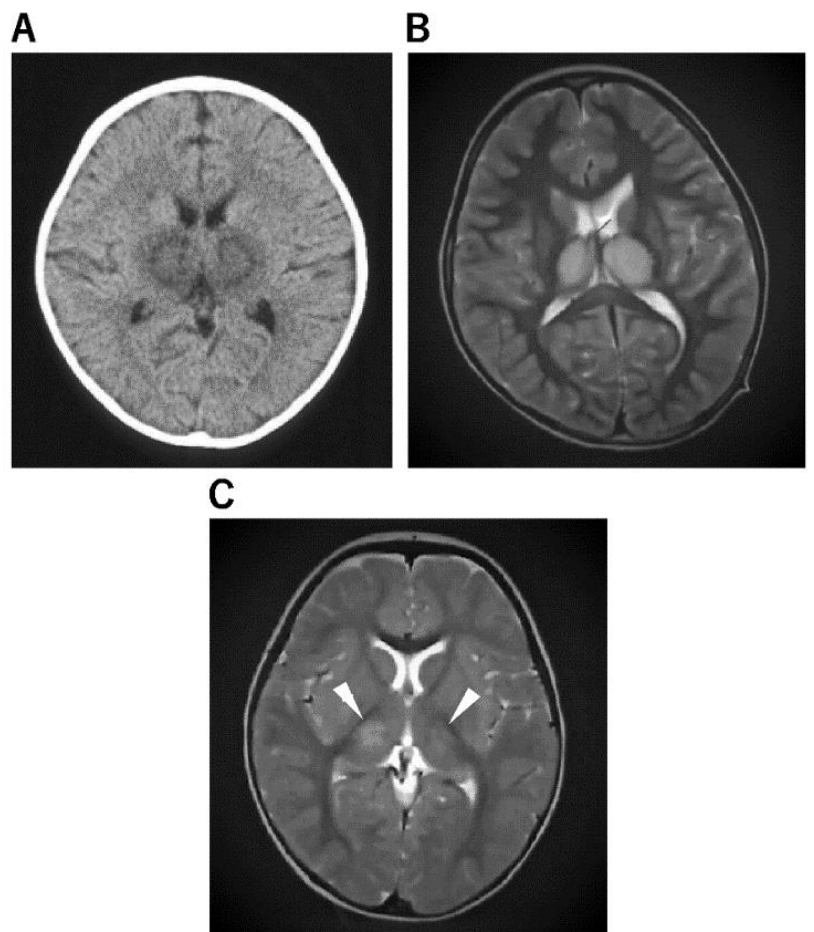
Figure 2. Imaging Characteristics of ANE. ( A ): An 11-month-old boy was admitted to the hospital after experiencing fever and vomiting. He was given a cold medicine prescription and sent home, but the next day, after a 3 min febrile convulsion, his loss of consciousness lasted 12 h, and a second 3 min convulsion was noted, so a CT was performed. He was diagnosed with ANE after a CT scan of the brain revealed abnormalities in the bilateral thalamus. ( B ): A 4-year-old boy visited the hospital with a high fever, vomiting, impaired consciousness, and convulsions. The rapid influenza A antigen test was positive, and MRI indicated abnormal signals in the bilateral thalamus not only on diffusion-weighted but also on T2 images, leading to the diagnosis of ANE. The patient was admitted to the intensive care unit immediately after being diagnosed with ANE. He was given cerebral sedation with high-dose barbital therapy and cerebral hypothermia at 34.5 ◦ C for 48 h, which was followed by TTM as temperature control therapy, IVIG high-dose therapy, and mPSL steroid pulse therapy. Mitochondrial cocktail therapy was used in combination with 2 months after onset; the patient was able to walk, and 4 months later, his speech function had recovered to the same level as before the onset. ( C ): A 1-year and 2-month-old girl was admitted to the hospital with fever and partial seizures. After an MRI the next day, the T2-weighted image showed abnormal signals in the bilateral thalamus and diagnosed ANE. She was treated in the intensive care unit with 72 h 34.5 ◦ C brain hypothermia, steroid pulse therapy, IVIG, and mitochondrial cocktail therapy. The patient was given cerebral sedation with high-dose barbital therapy and she was treated with dextromethorphan, which saved her life, but she was left with severe neurological sequelae.